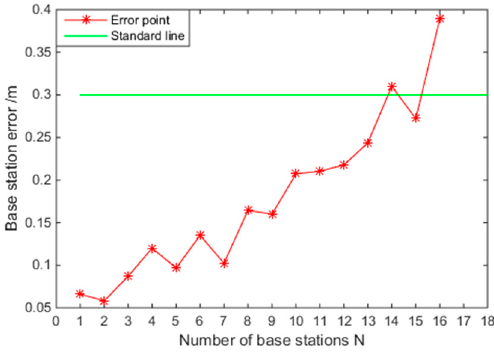
Figure 15. Maximum number of base stations when positioning error is over the exception value.